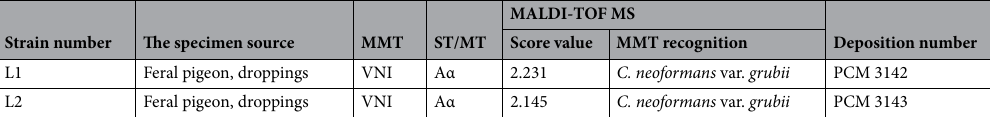
Table 2. The results of URA 5-RFLP, sero/mating type and MALDI-TOF MS analyses. In bold—isolates with score value below 1.7 or misidentified on subspecies level by MALDI-TOF MS. VL—strains obtained from Veterinary Laboratory Vetlab. VNIV 1 —VNIV strains presenting an atypical URA 5-RFLP banding pattern. MMT major molecular type; according to URA 5-RFLP. ST/MT sero- and mating type. AD hybrid = C. neoformans var. grubii x C. neoformans var. neoformans . PCM—Polish collection of microorganisms. *,^,#, ~ , + ,**,“– multiple isolates obtained from the same